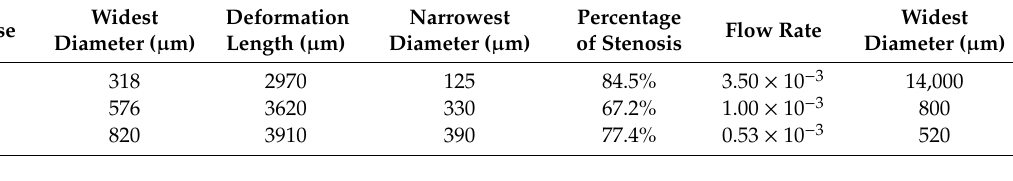
Table 2. Simulated Wall Shear Rates in Microchannels.